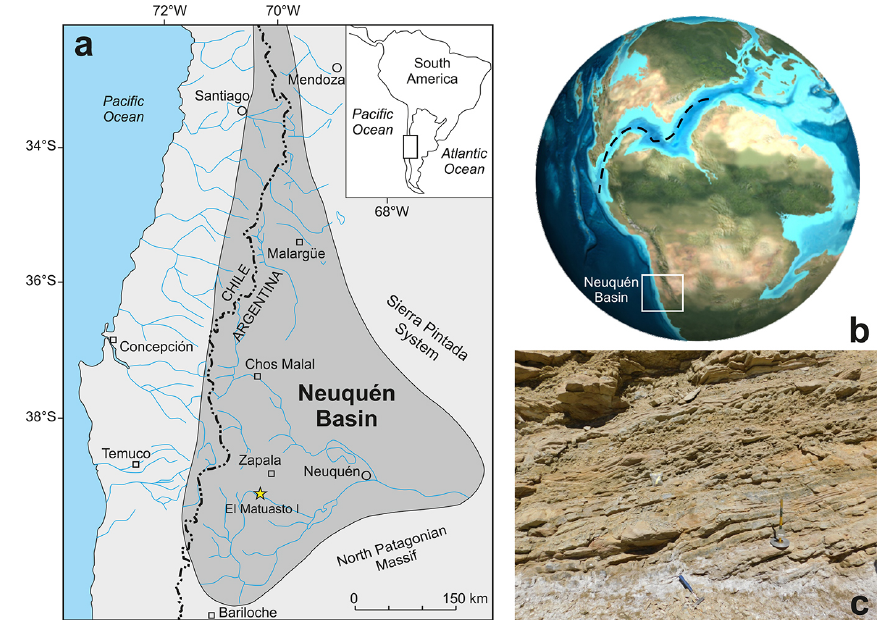
Figure 1. (a) Geographical setting of the Neuquén Basin and the El Matuasto I section (Argentina) (adapted after Howell et al., 2005). (b) Palaeogeographic reconstruction for the Early Jurassic showing the possible connection between the Pacific and Tethys oceans dur- ing the Pliensbachian (adapted after Global Paleogeography, http://plate-tectonic.narod.ru/globalpaleogeophotoalbum.html, last access: 12 March 2022). (c) View of the El Matuasto I section, Los Molles